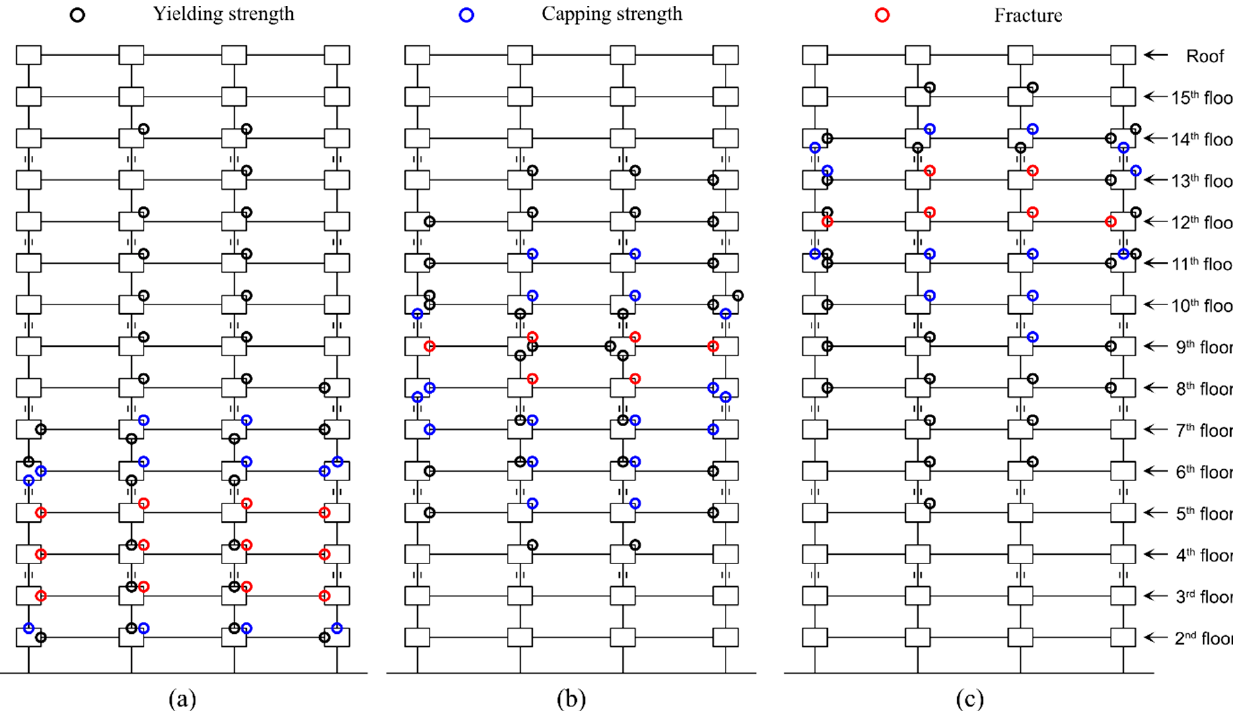
Figure 5. Overstrength factor ( Ω ) and period-based ductility ( 𝜇 (cid:3021) ) of steel OMFs obtained from push- Figure 5. Overstrength factor ( Ω ) and period-based ductility ( µ T ) of steel OMFs obtained from over analyses, ( a ) The Ω values, ( b ) The 𝜇 (cid:3021) values. pushover analyses, ( a ) The Ω values, ( b ) The µ T values.